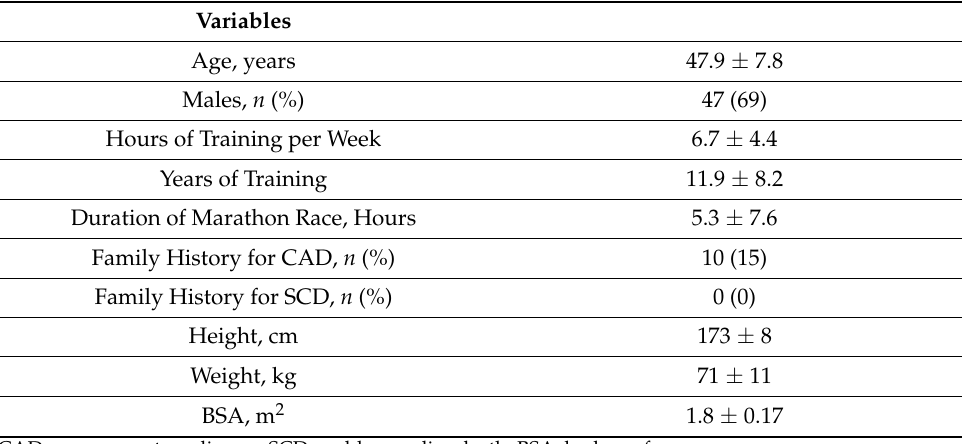
Table 1. Demographic characteristics of the study population.